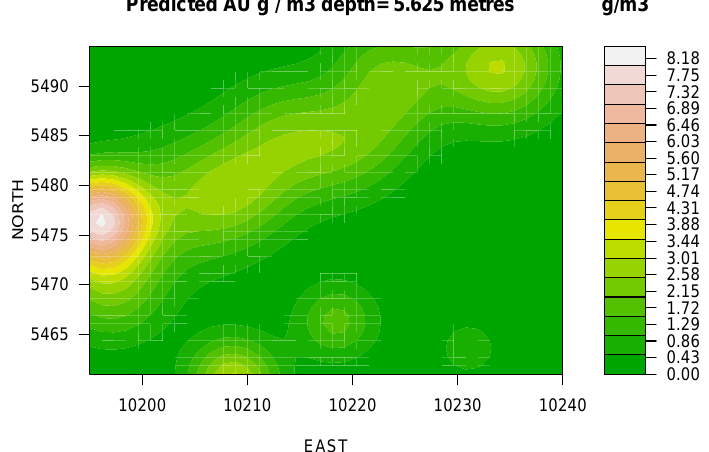
Figure 4. Predicted gold content at 5.625 m below the surface. Model renders a consistent increase of the apparent grade with the depth. The distribution reflects insignificant reshaping and suggests the displacement of